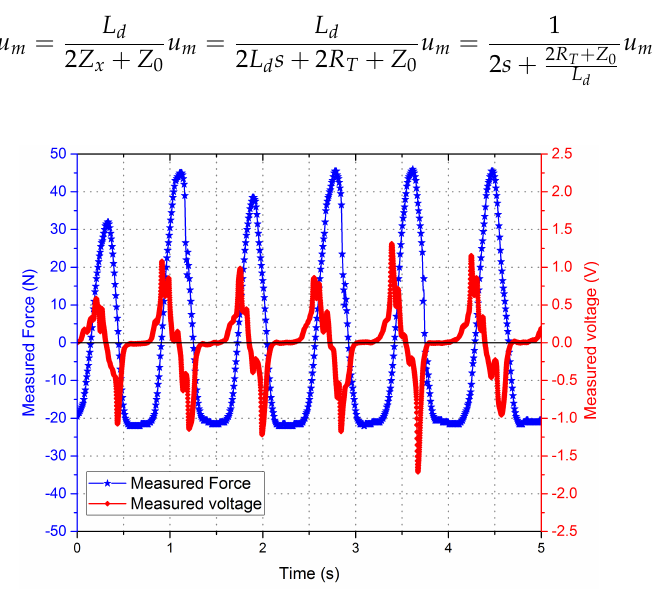
Figure 6. Measured force and the measured voltage curves with drive current = 0 A.